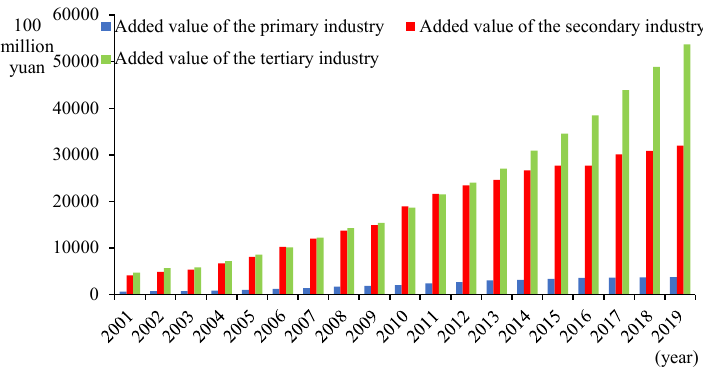
Figure 11. Development trend of value added of marine industry in China